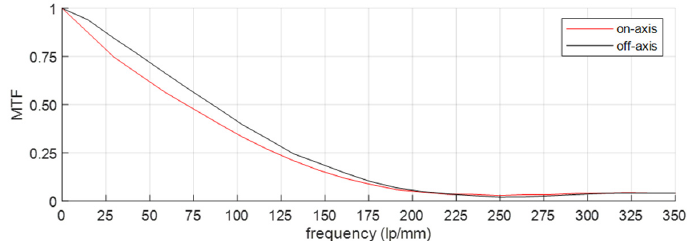
Figure 8. Image of the slanted edge evaluating the image quality of the visible and NIR camera channels: ( a ) on-axis positioning, ( b ) off-axis positioning (at 179°), indicating the presence of barrel distortion.